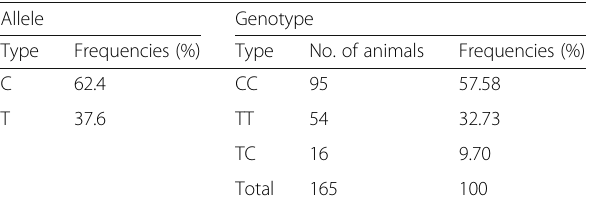
Table 1 Alleles and genotype frequencies for the DGAT1 gene in Zaraibi goat